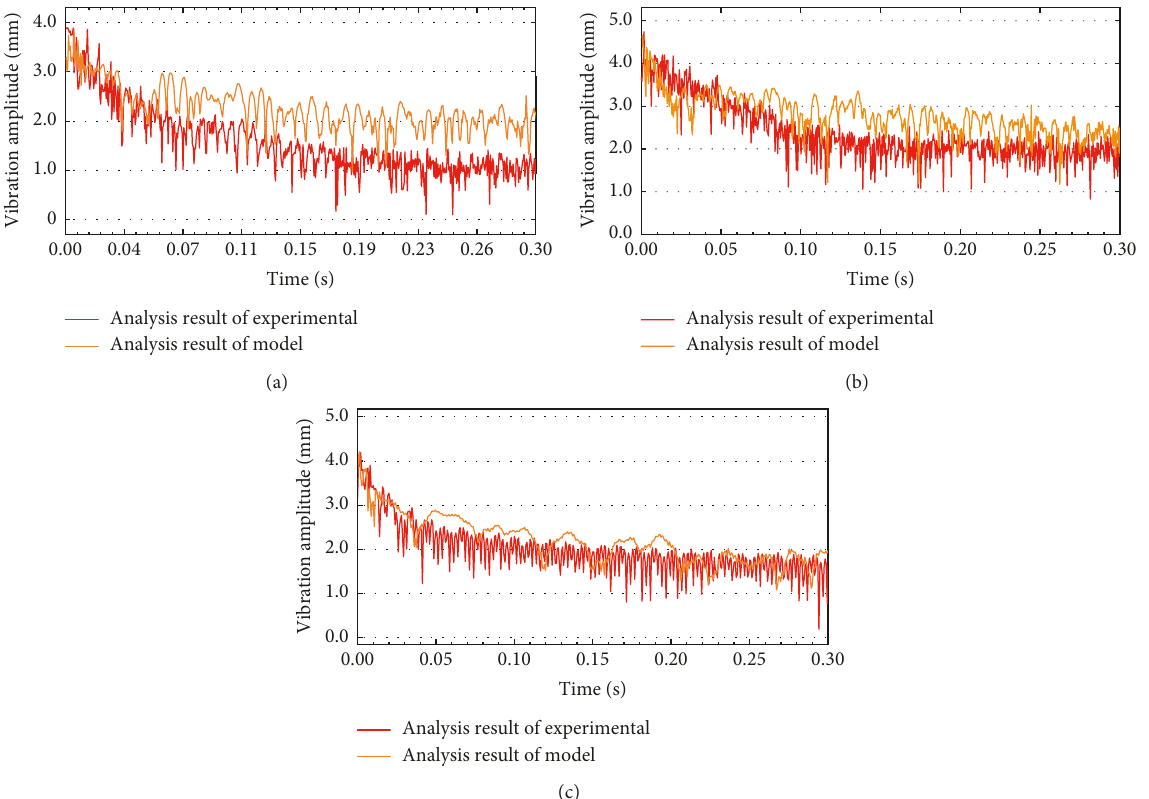
Figure 13: Variation of displacement amplitude of tubing wall with time during gas injection. (a) Vertical well section. (b) Inclined well section. (c) Horizontal